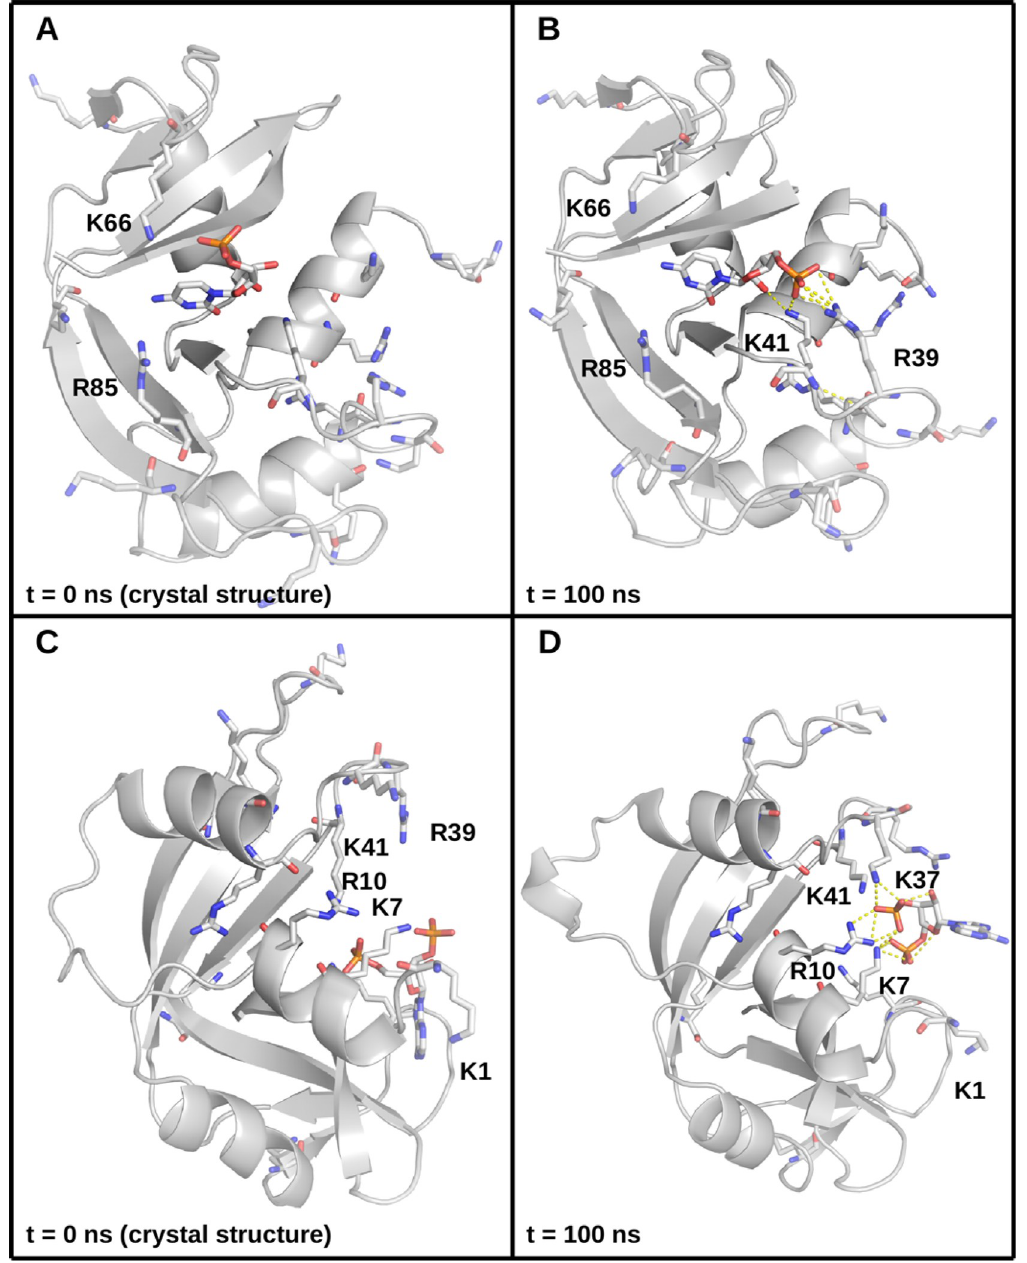
Fig 4. Comparison between crystal and simulated structures. (A) The RNase A–C5P complex from a crystal structure. The protein backbone is in cartoon representation, colored in gray. Lysines, arginines, and the ligand are given in stick representation with carbon atoms in white, nitrogens in blue, oxygens in red, and phosphorus in orange. Certain lysine and arginine residues are labeled. (B) The RNase A–C5P complex after 100 ns of production dynamics; polar contacts are shown as dotted lines. (C) The RNase A–A3P complex from a crystal structure. The protein backbone is in cartoon representation, colored in gray. Lysines, arginines, and the ligand are given in stick representation with carbon atoms in white, nitrogens in blue, oxygens in red, and phosphorus in orange. Certain lysine and arginine residues are labeled; polar contacts are shown as dotted lines. (D) The RNase A–A3P complex after 100 ns of production dynamics.